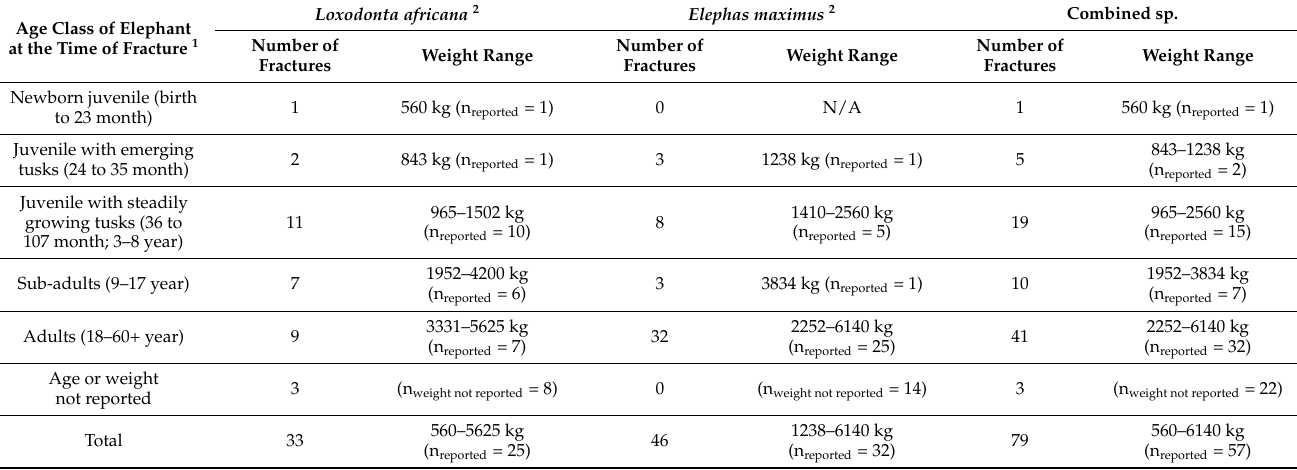
Table 3. The fractures of this study’s data set in relation to age, weight and species of elephant at time of